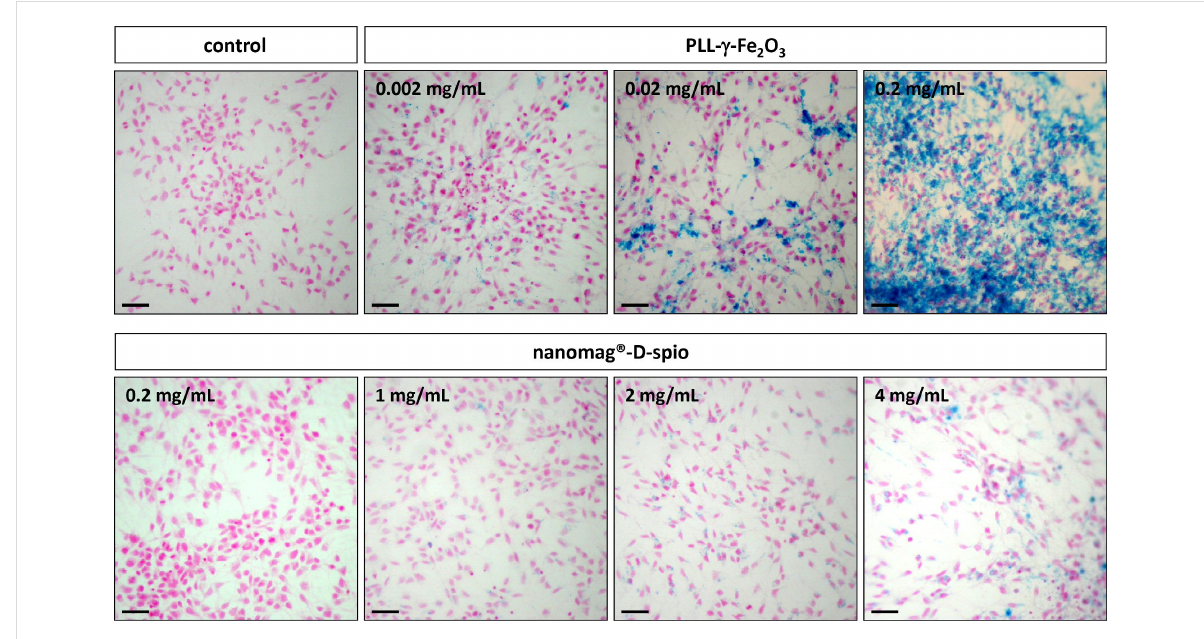
Figure 2: PLL- γ -Fe 2 O 3 and nanomag ® -D-spio nanoparticles labeling of NSCs. Light microscopy after Prussian Blue staining of NSCs labeled with dif- ferent concentrations of PLL- γ -Fe 2 O 3 (upper panel) and nanomag ® -D-spio nanoparticles (lower panel) indicated the distribution of iron oxide nanopar- ticles. Nuclear Fast Red staining showed the position of nuclei. Scale bar: 50 µm.